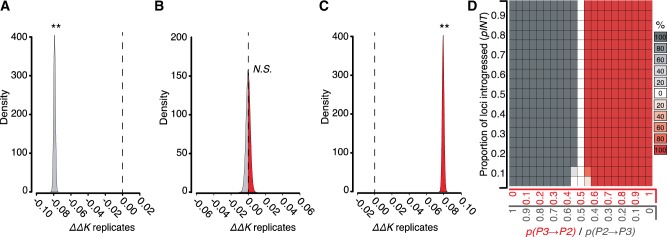
—2×DIP analysis of simulated introgression. Genomes were simulated according to steps 1–3 in supplementary figure S1, Supplementary Material online. Genomes were simulated under unidirectional P2⇒P3 introgression (A), symmetrical bidirectional P3⇔P2 introgression (B), and unidirectional P3⇒P2 introgression (C). Simulation parameters are as follows: (A), n = 5,000, pINT = 0.5, p(P3⇒P2) = 0; (B), n = 5,000, pINT = 0.5, p(P3⇒P2) = 0.5; (C), n = 5,000, pINT = 0.5, p(P3⇒P2) = 1. 2×DIP was applied to each genome to yield a sampling distribution of ΔΔK. ** indicates significant departure from 0 (P < 0.01). (D) A plot scanning pINT and p(P3⇒P2) as in figure 3D. Red boxes indicate significant (P<0.05) P3⇒P2 2×DIP signature (see panel C). Gray boxes indicate significant (P<0.05) P2⇒P3 2×DIP signature (see panel A). Five replicate genomes were simulated for each parameter value. The shading of the boxes corresponds the percentage of replicates for which 2×DIP significantly indicated a directional signature, as specified by the key to the right of the plot. Unshaded boxes indicate zero replicates yielded a significant directional signature (i.e., all five replicates failed to reject the null hypothesis of symmetrical introgression; see panel B).